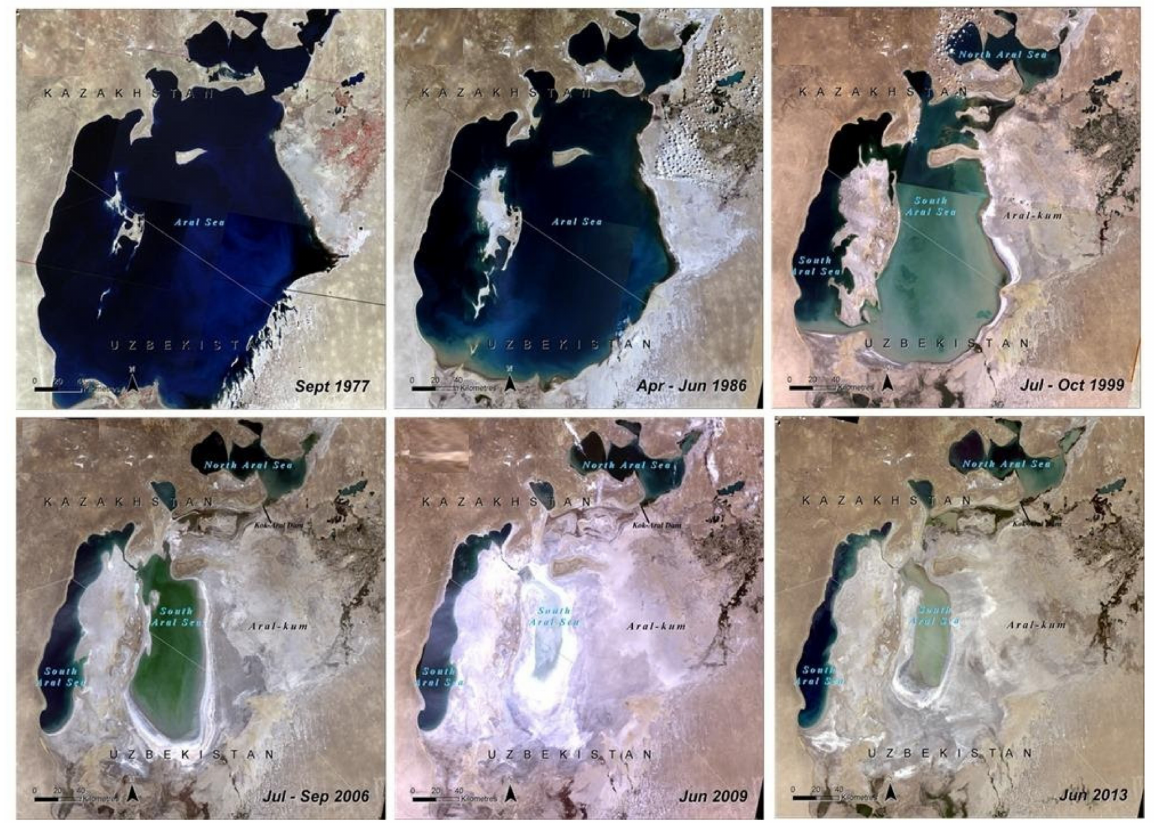
Figure 2. Landsat satellite imagery mosaics showing visible changes of the Aral Sea.Source: USGS/NASA; visualisation by UNEP/GRID-Sioux